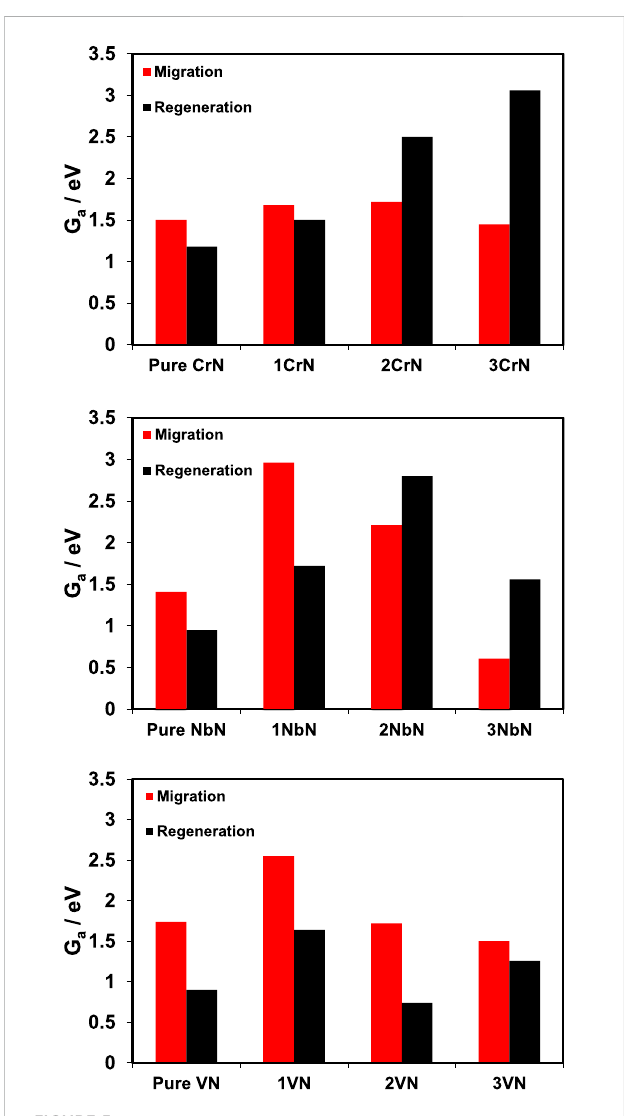
The activation free energy of the vacancy migration to the bulk compared with the activation free energy of vacancy re fi lling. The more positive the value is, the slower would be the rate of the reaction accordingtok= ν exp( − E a /k B T).SinceZrNoverlayersonTiNdonot result in ammonia formation, these analyses have not included ZrN